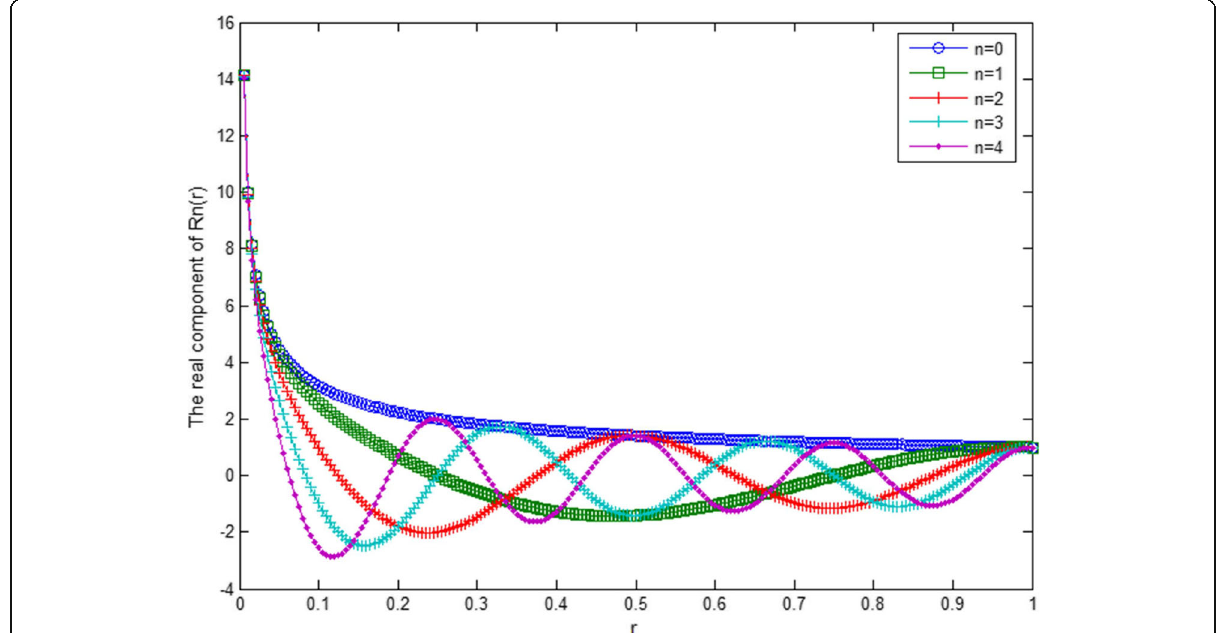
Fig. 2 Real component of radial function R n ( r ) of EMFs with n = 0, 1, 2, 3,